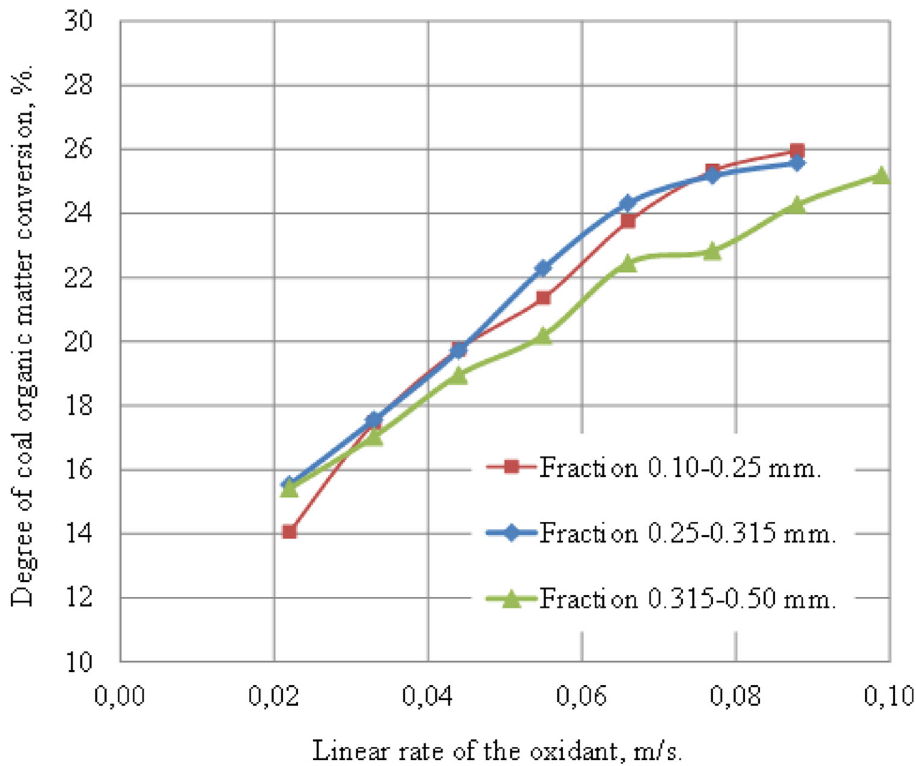
Fig. 5 The degree of coal organic matter conversion versus OLV and coal particles’